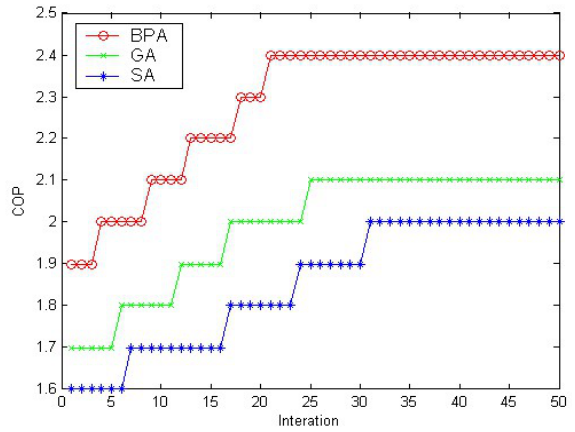
Figure 12. BPA performance test.